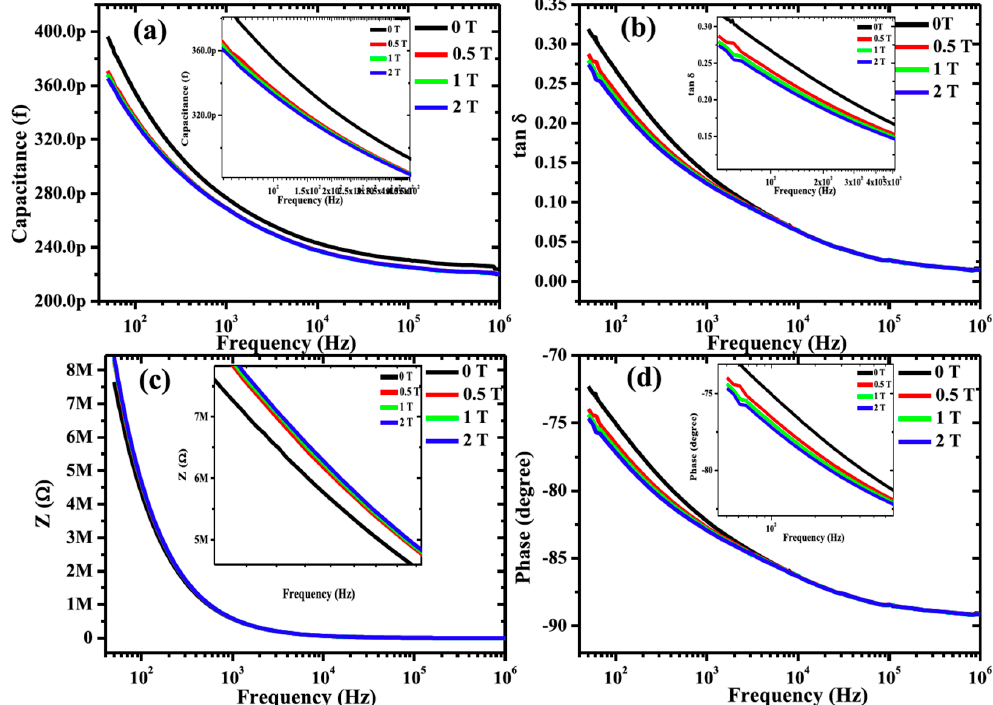
Figure 3. Frequency dependence of ( a ) capacitance, ( b ) loss, ( c ) impedance, and ( d ) phase of PN2 composite at different static magnetic field. Figure reproduced with permission from [66] .